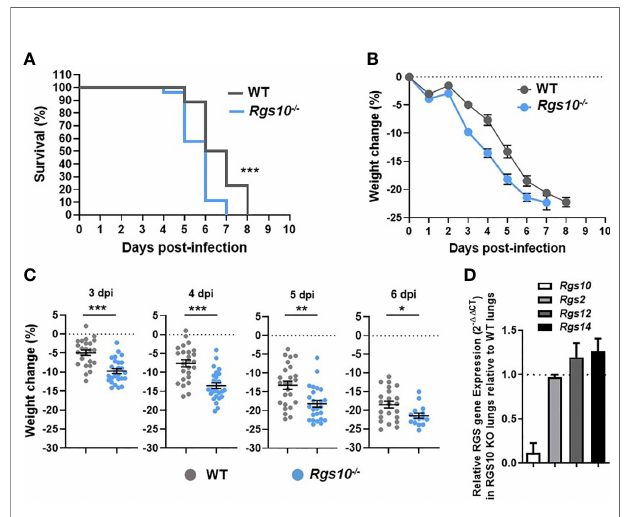
FIGURE 1 | Rgs10-/- mice exhibit enhanced mortality and weight loss post- IAV infection. WT (n=25) and Rgs10-/- (n=26) mice were inoculated intranasally with 100 PFU of the in fl uenza A/Puerto Rico/8/1934 H1N1 (PR8) virus and (A) survival and (B) average weight changes were monitored for up to 8 days. (C) Individual animal weight changes are shown for each day between 3 to 6 dpi. Each circle represents a separate animal. The data were pooled from two independent experiments. Data were analyzed for statistical differences using Mann – Whitney U test. Data are presented as mean ± SEM where *p < 0.05; **p < 0.01; ***p < 0.001. (D) RNA was isolated from the lung homogenates of uninfected wild-type (WT) and Rgs10-/- mice (n=3 per strain), Rgs10, Rgs2, Rgs12 and Rgs14 transcript levels were measured using quantitative RT-PCR and normalized on the endogenous housekeeping gene b -actin. The relative expression was calculated by using the 2- DD Ct method and the gene expression ratio of Rgs10-/- over WT mice are shown for each gene. The dashed line indicates endogenous expression in uninfected WT